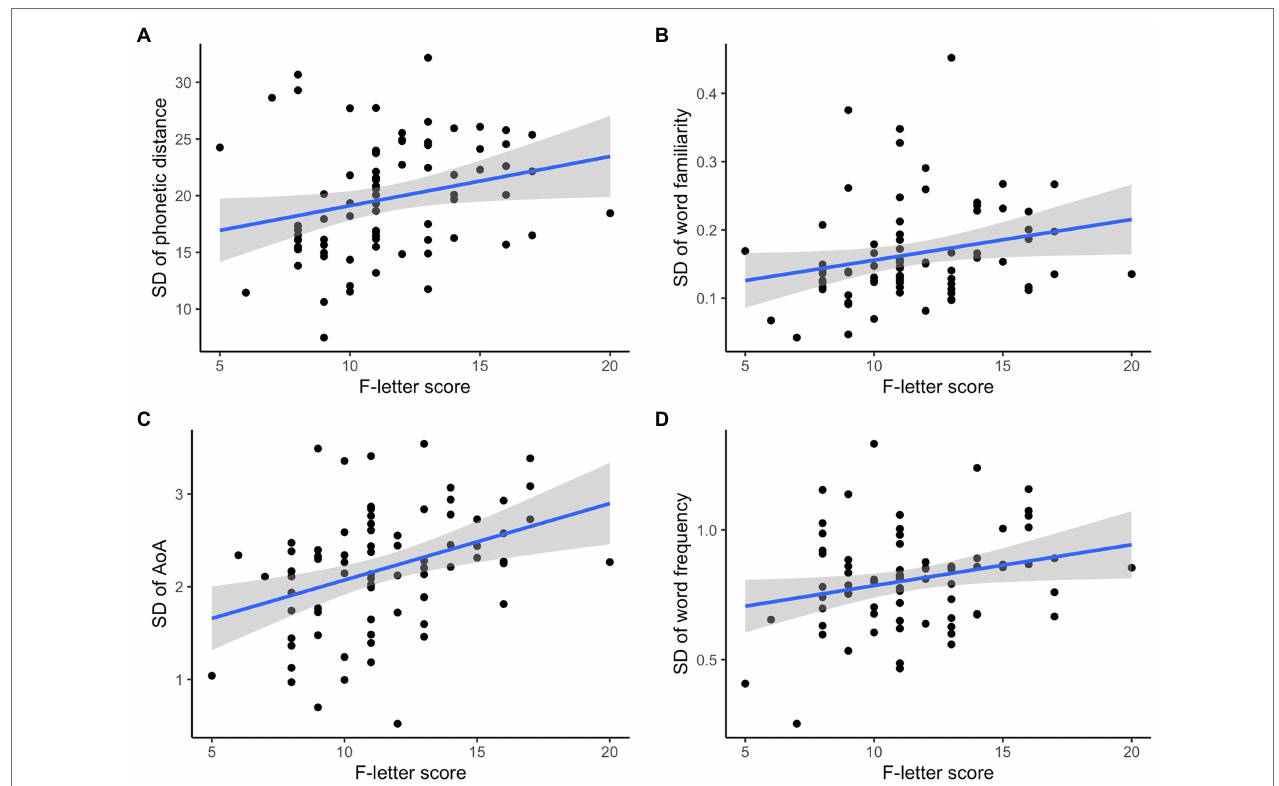
FIGURE 4 | F-letter performance and SD of the language measures.